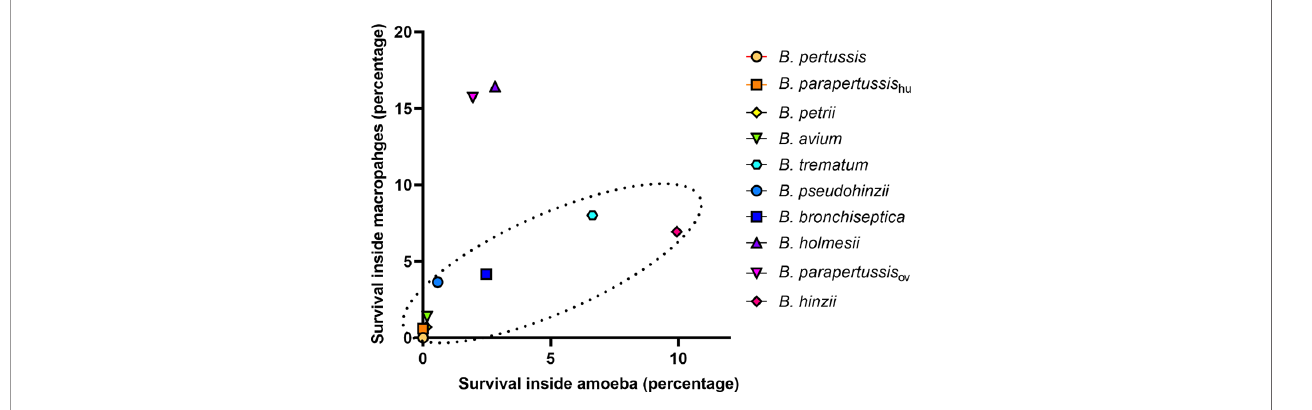
FIGURE 10 | Correlation between Bordetella -amoebal interaction and mammalian cell intracellular survival. The survival percentage inside sori is located on the X axis and the survival percentage inside murine RAW 264.7 macrophages located on the Y axis. The Bordetella species highlighted within the dash oval have a correlation coef fi cient value at 0.889035 for these two variables.